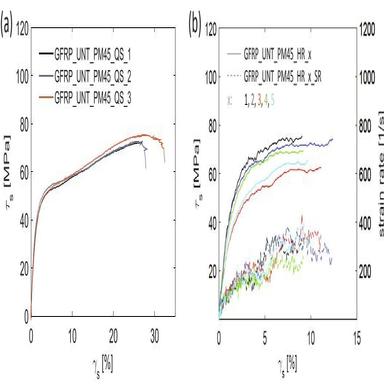
Shear stress-shear strain curves at QS (a) and HR (b) loading.